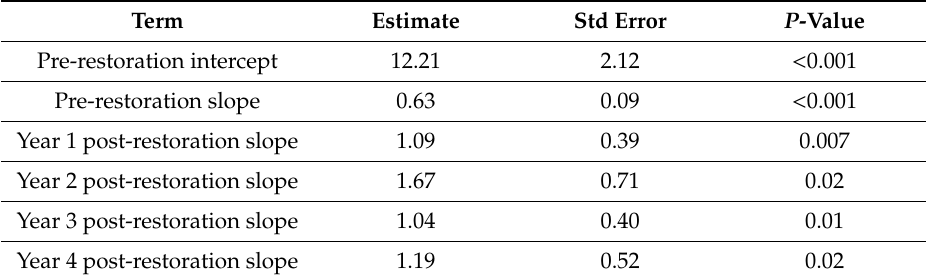
Table 3. Regression equations for soil moisture percent between Marian Meadow and Control Meadow for pre-restoration (2014–2015 water year (WY)) and each year after restoration (2016–2019 WY).